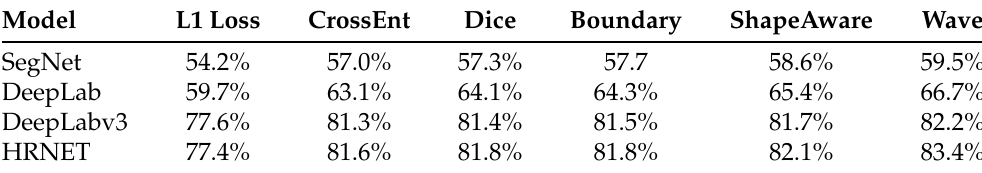
Table 1. This table contains the average accuracy results of five independent runs on the Cityscapes dataset using four different network architectures (rows) and six different loss functions for semantic